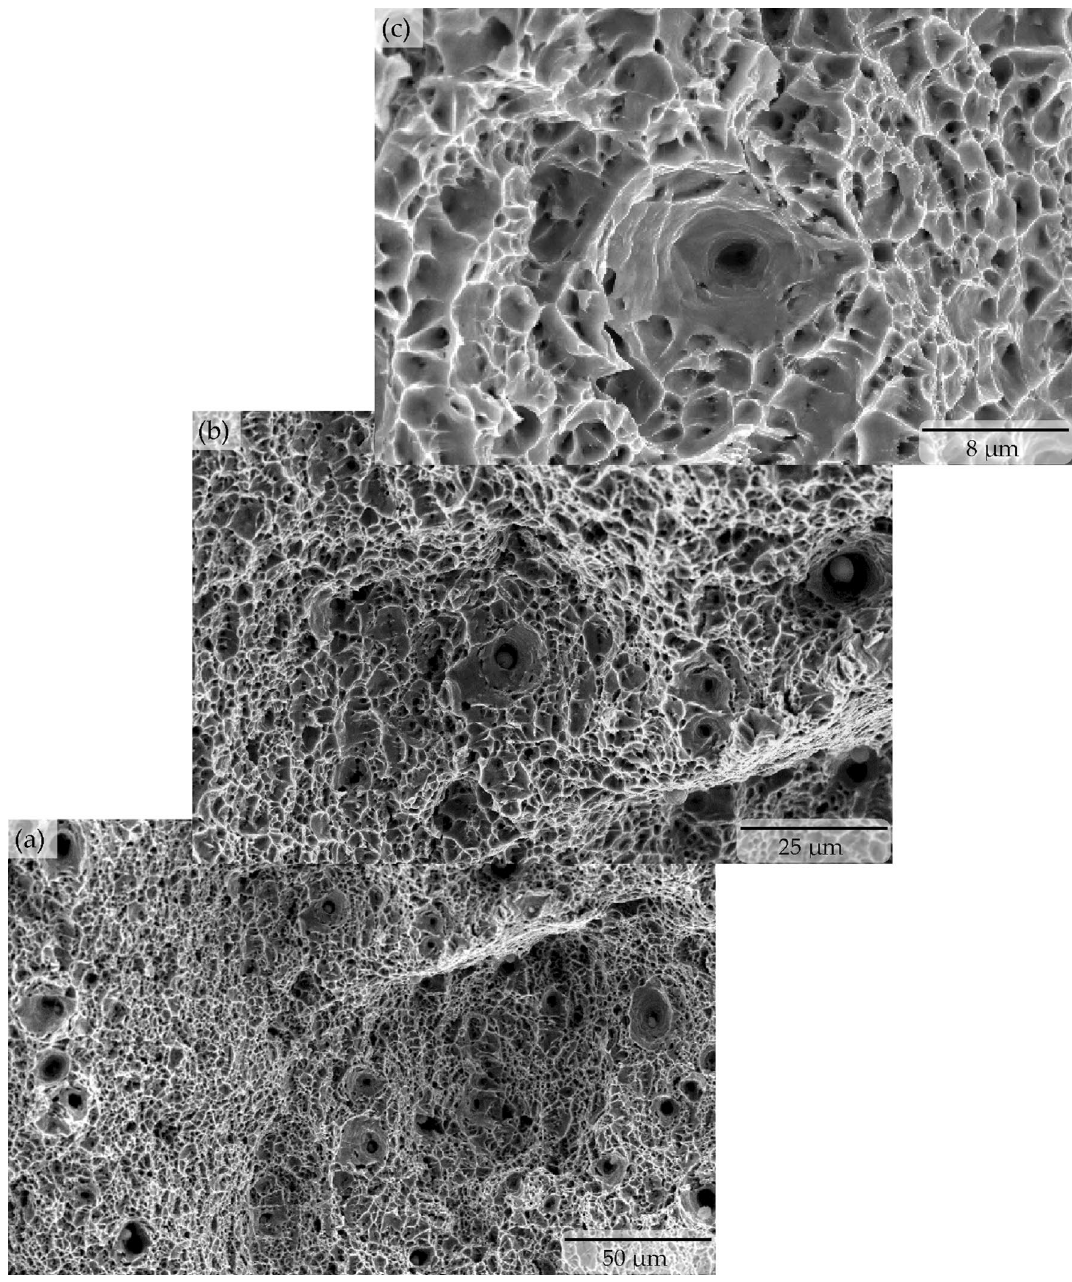
Figure 7. Scanning electron microscopy showing fine dimples dominated ductile fracture surface in pre-heat treated microalloyed low carbon